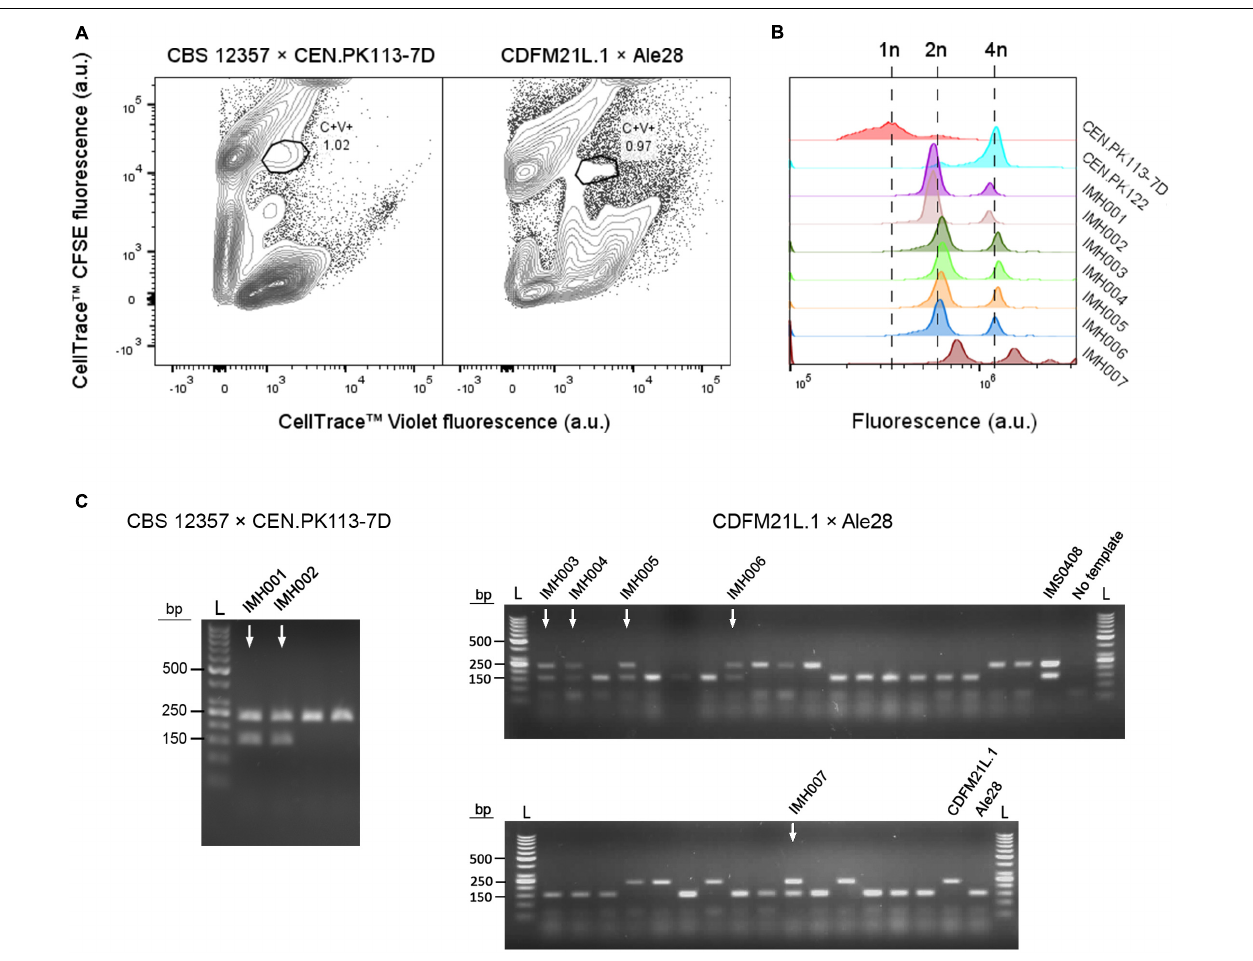
FIGURE 3 | Enrichment of interspecies hybrids without selectable phenotypes from CBS 12357 ( S. eubayanus, sporulated) and CEN.PK113-7D ( MATa ) and from CDFM21L.1 ( S. eubayanus, sporulated) and Ale28 ( S. cerevisiae, sporulated). (A) Fluorescence contour plots of mating cultures between CBS 12357 (CFSE) × CEN.PK113-7D (Violet) and CDFM21L.1 (CFSE) × Ale28 (Violet). Gated areas were used for sorting cells, event rates of each gate are indicated as a percentage of the total population size. (B) Flow cytometric quantification of the genome content of constructed hybrids using SYTOX Green staining. S. cerevisiae strains CEN.PK113-7D and CEN.PK122 were used as a haploid and diploid control, respectively. (C) Multiplex PCR amplification of the S. cerevisiae specific MEX67 gene (150 bp) and the S. eubayanus specific FSY1 gene (228 bp) in single-cell isolates of the double-stained populations from CBS 12357 × CEN.PK113-7D and CDFM21L.1 × Ale28 mating cultures. For CBS 12357 × CEN.PK113-7D, 4 of the 22 tested isolates are shown. Genomic DNA of S. cerevisiae Ale26, S. eubayanus CDFM21L.1 and S. cerevisiae × S. eubayanus IMS0408 were used as controls. Hybrid isolates are indicated by arrows. L: Generuler 50 bp DNA